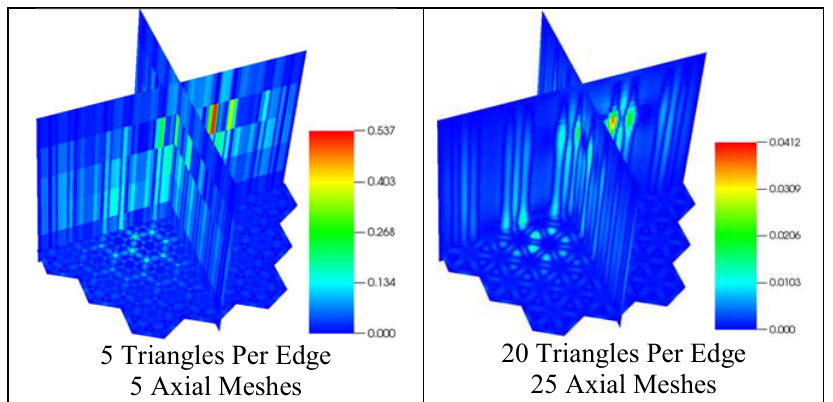
Figure 4. DIF3D-FD Absolute Error Profiles for Manufactured Spatial